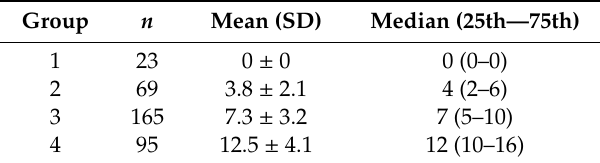
Figure 4. Item response theory analysis for the susceptibility of dental caries at the block level. ( A ) Item response curve; ( B ) item information curve; item information of dental caries in mandibular anterior teeth and both maxillary and mandibular anterior teeth had high item information. Table 2. The number of dental caries in the groups